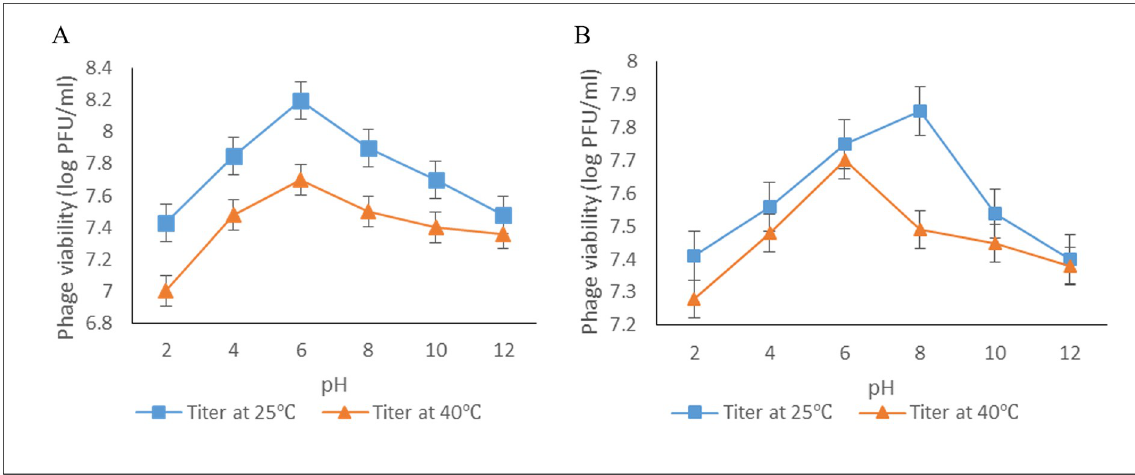
Fig 5. Effect of pH on phage viability at 25˚C and 40˚C. A) Phage UPEC04. B) Phage UPEC10. Phage viability was determined by obtaining the phage titers at the different pH using the agar overlay method. Values are an average for duplicate tests.